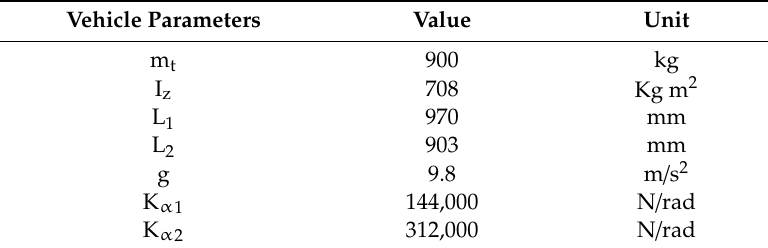
Table 5. Main parameters of vehicle model.